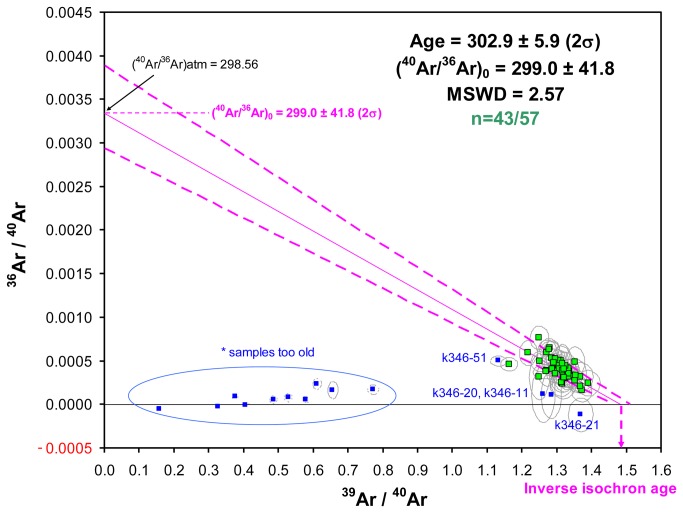

36Ar/40Ar vs 39Ar/40Ar inverse isochron diagramfor all the data (n=57) with ellipse error at 2σ excluding 14 samples (blue squares): 1) *samples too old (quoted with * in Table 2) (n=10); 2) K346-20, K346-11 with a too high 39Ar/36Ar ratio and K346-21 with a negative 36Ar/40Ar ratio because 36Ar was underestimated; 3) K346-51 was eliminated otherwise the MSWD is 3.2 and the atmospheric ratio is not reached.